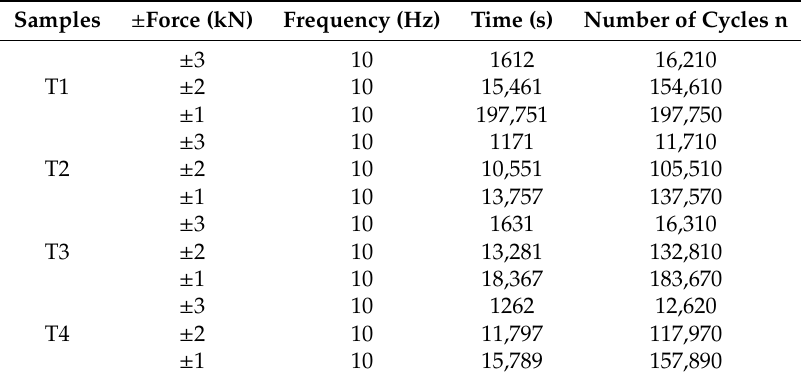
Table 12. Results obtained after fatigue testing of the samples.